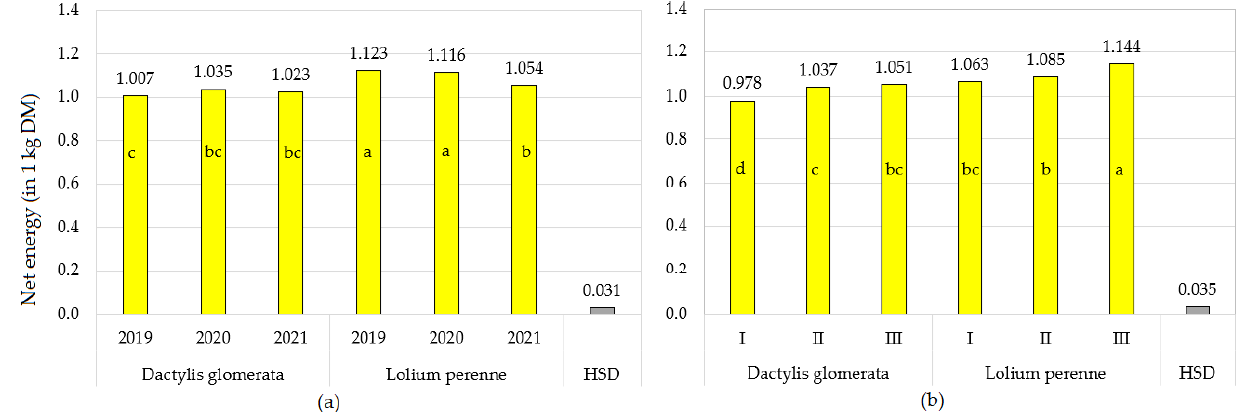
Figure 1. Net energy of Dactylis glomerata and Lolium perenne in consecutive ( a ) growing seasons and ( b ) harvests (in 1 kg DM). Means in columns marked with the same lower-case letters do not differ